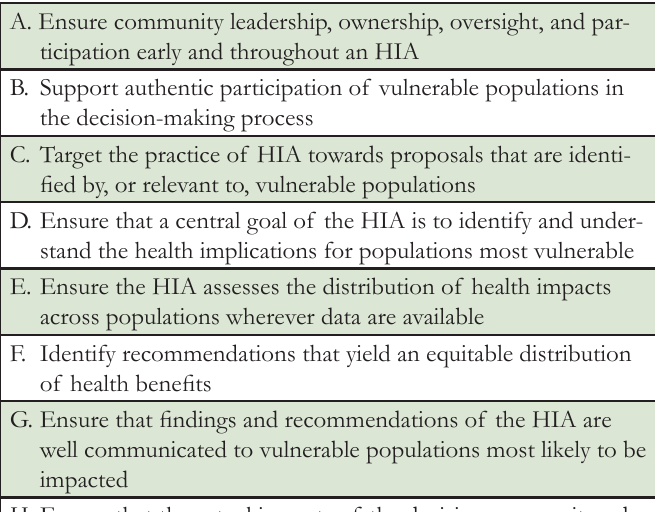
Table 1: Strategies for promoting equity in HIA (from Heller et al.,